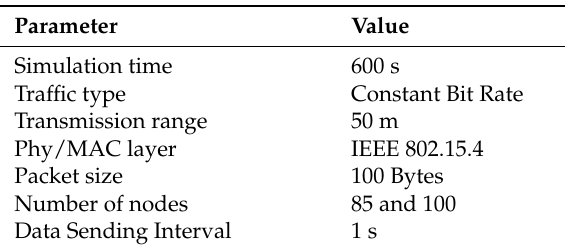
Table 3. Environment parameters in